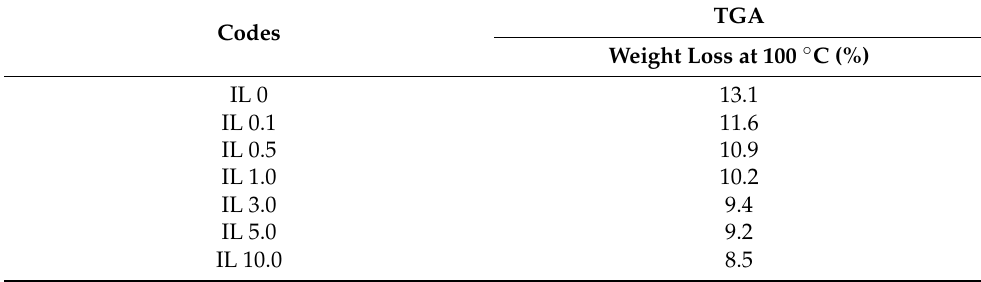
Table 2. TGA data of wet silica ionogels.